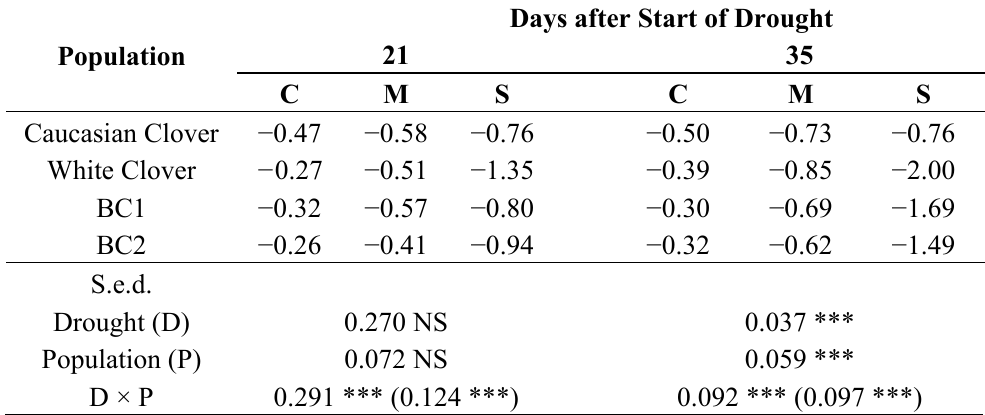
Table 2. Leaf water potential (MPa) of Caucasian clover, white clover, BC1 and BC2 hybrids after 21 and 35 days at three levels of drought. C––control treatment, M––moderate moisture stress, S––severe moisture stress. Population